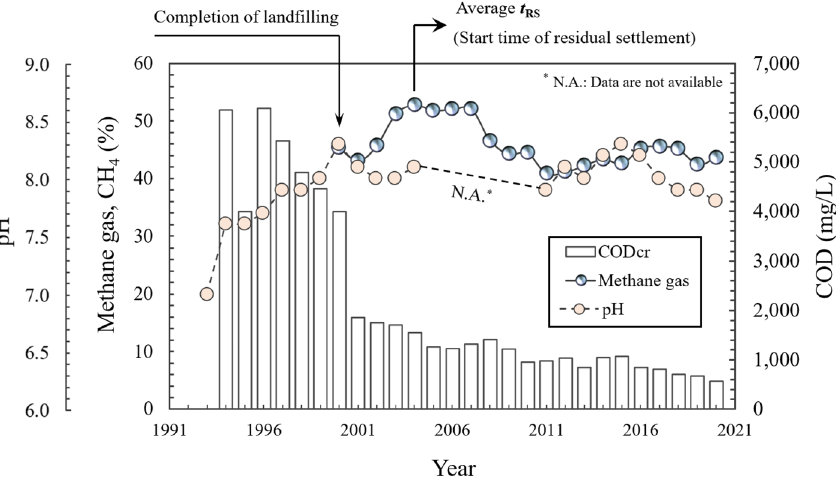
Figure 5. Chemical oxygen demand (COD), methane (CH 4 ) gas, and pH of landfill #1 (GLC,